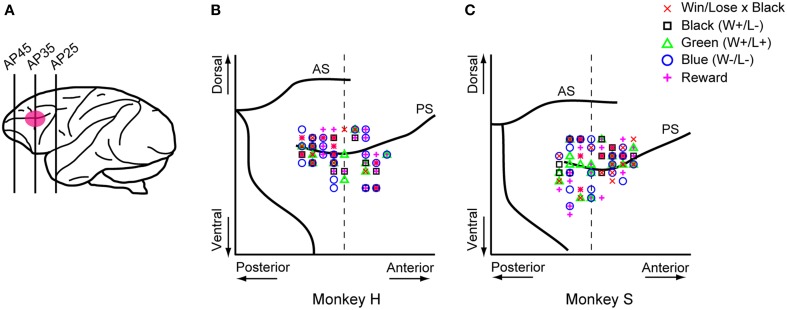
Sites where each type of neuron was recorded. (A) Recording areas. Recording areas are highlighted with a pink ellipse on a lateral view of the monkey brain. We recorded LPFC neurons in both the upper and lower banks of the principal sulcus. Most of the recordings were made in the region between AP30 and AP40. AP, anterior-posterior. (B,C) Recording sites of each type of neuron were mapped onto comparative locations of the right hemisphere of each monkey's brain based on magnetic resonance images. Red crosses, black squares, green triangles, blue circles, and magenta plus signs represent Win/Lose x Black, Black, Green, Blue, and Reward type neurons, respectively. There were no biases in the recorded areas for each type of neuron across four parts separated by the dorsal and ventral parts from the principal sulcus and the anterior and posterior parts from AP 35 (chi-squared test, p > 0.05). The vertical dashed line represents AP 35. AS, arcuate sulcus; PS, principal sulcus.